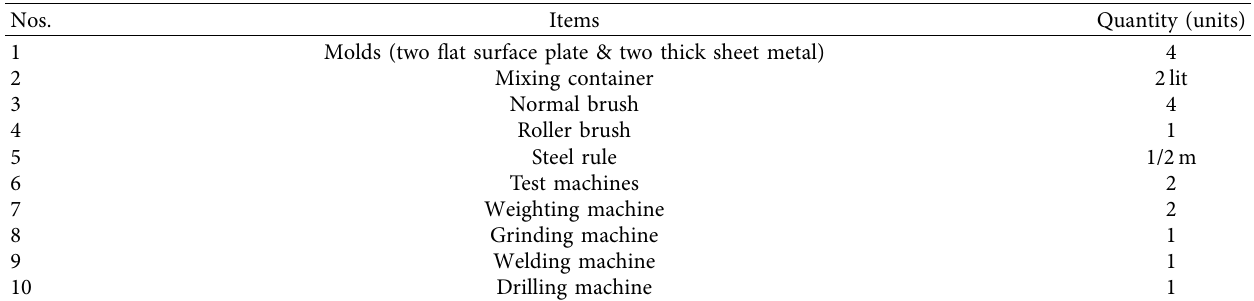
Table 2: Equipment